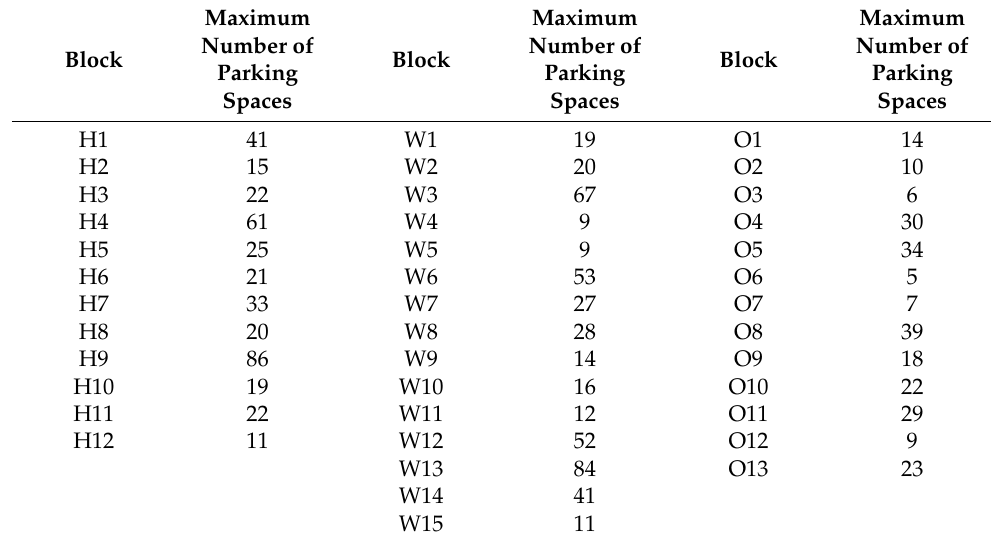
Figure 4. Actual distribution network topology and charging station service area. Table 1. Maximum number of parking spaces in each block.